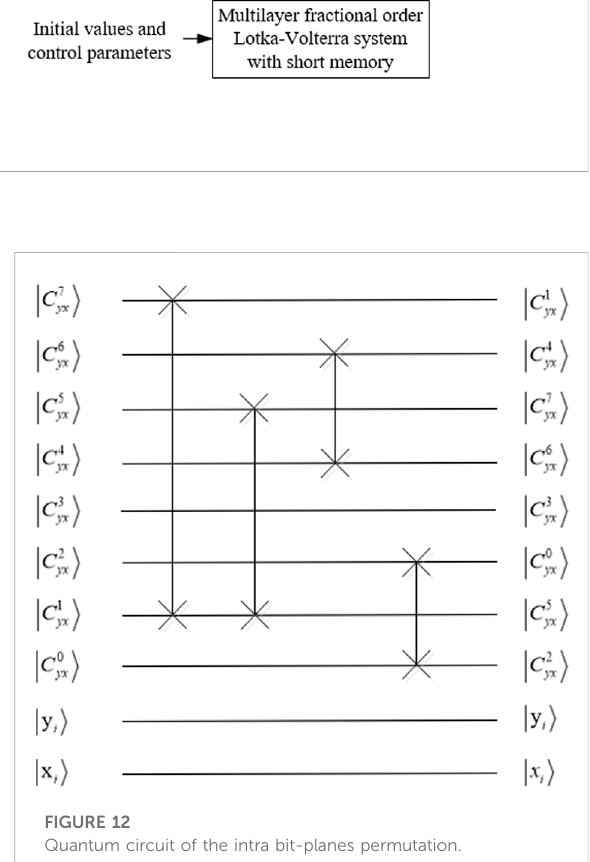
FIGURE 12 Quantum circuit of the intra bit-planes